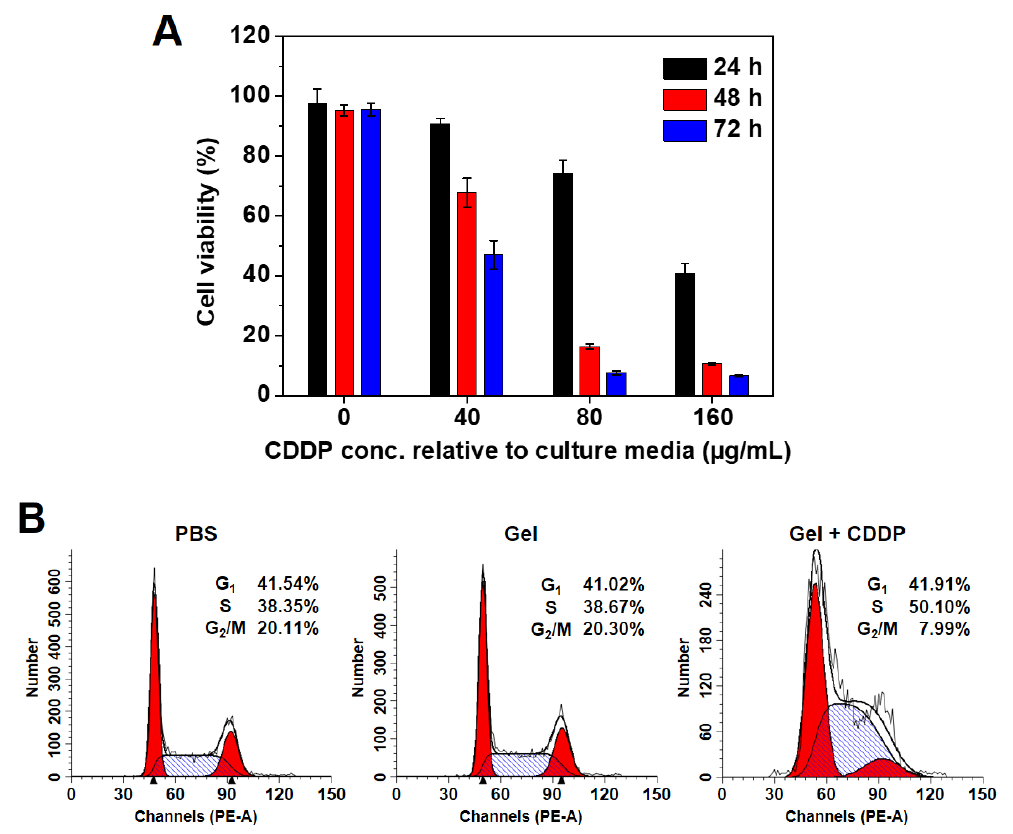
Figure 4. ( A ) In vitro cytotoxicity of CDDP-loaded hydrogels against MCF-7 cells. ( B ) Flow cytometric analysis of cell cycle distribution of MCF-7 cells induced by CDDP-loaded hydrogels.